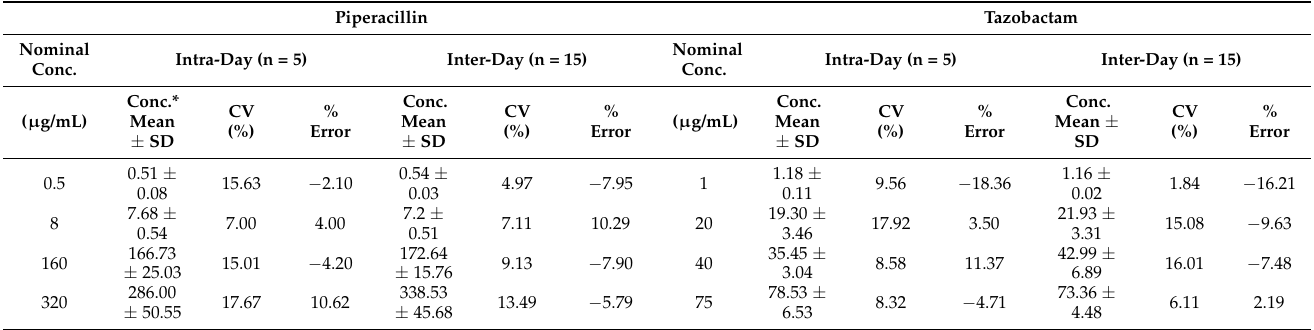
Table 1. Intra-day (n = 5) and inter-day precision and accuracy data for the quantitation of piperacillin and tazobactam in human plasma.